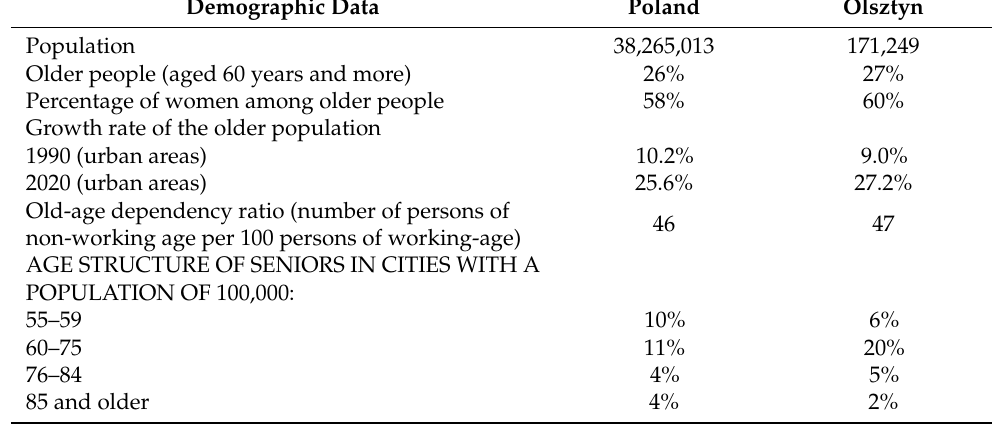
Table 3. Demographic data for Poland and Olsztyn. Source: own elaboration based on [76]. Demographic Data